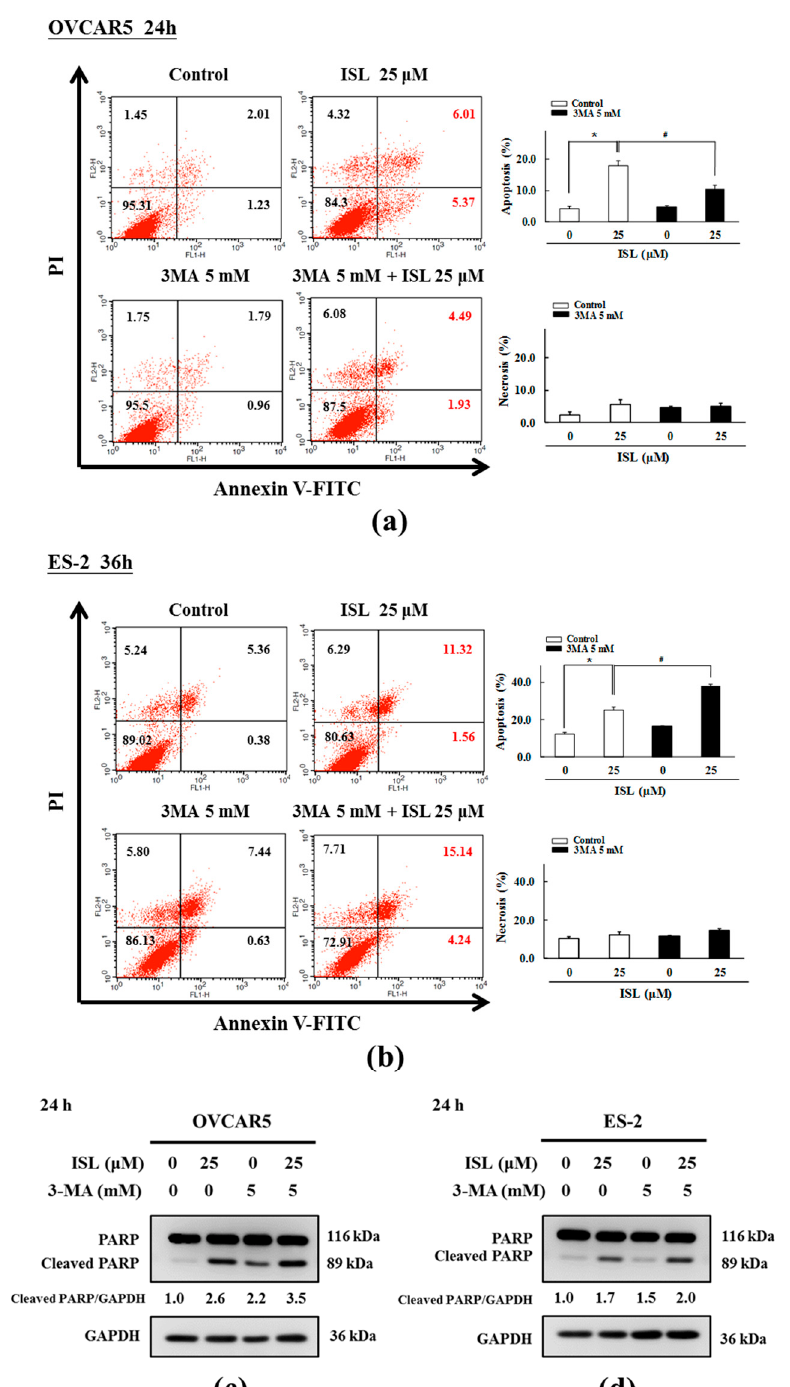
Figure 5. ISL induced apoptosis in ovarian cancer cells. OVCAR5 and ES-2 cells were treated with ISL 25 µ M for 24 or 36 h with or without autophagy inhibitor (3-MA) pretreatment (5 mM, 4 h), cells were harvested and stained with Annexin V-FITC (fluorescein isothiocyanate) and PI (propidium iodide), and apoptotic cell death was analyzed using flow cytometry, relative proportions of both early and late apoptosis are indicated in right lower and right upper quadrant, respectively in each treatment group ( a , b ). OVCAR5 and ES-2 cell lysates were separated by SDS-PAGE and analyzed on western blots with the apoptosis markers total PARP and cleaved PARP. GAPDH was used as a loading control. The values of the band intensity are expressed as the ratio cleaved PARP:GAPDH relative to control ( c , d ). * p < 0.05 compared with control group; # p < 0.05 compared with ISL 25 µ M group.